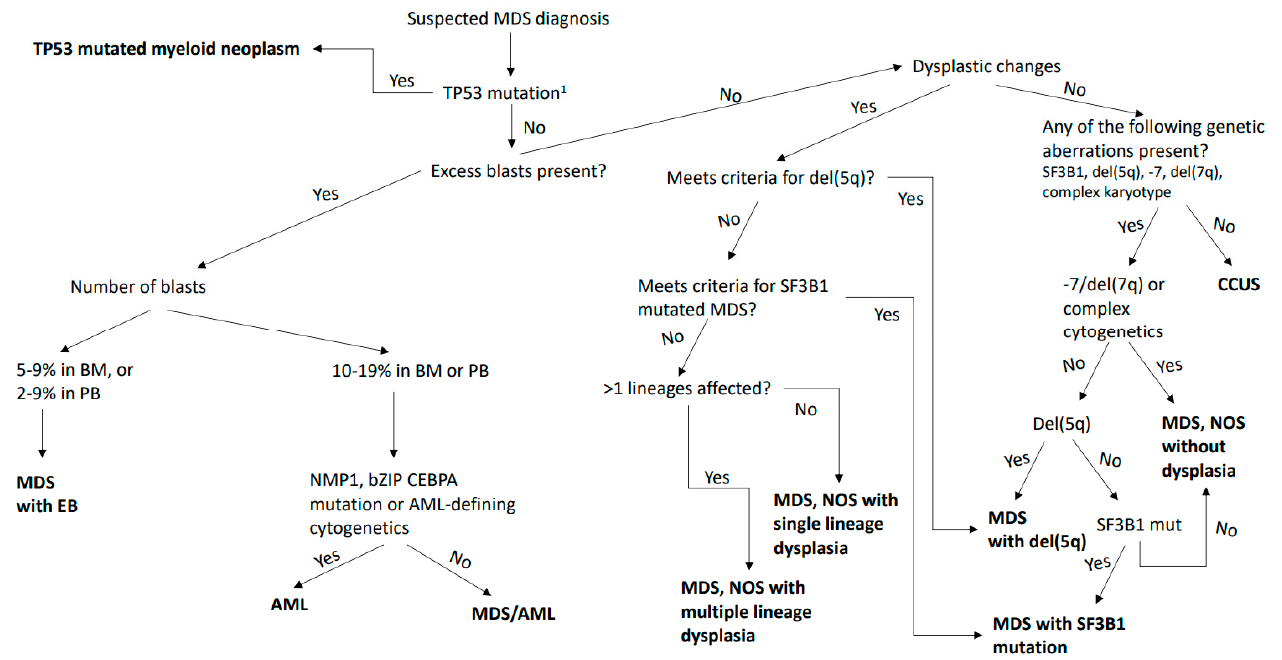
Figure 1. The classification algorithm of MDS based on the new changes. 1 Diagnosis of MDS/AML or AML with mutated TP53 can be made with any somatic TP53 mutation with VAF > 10%, whereas MDS with mutated TP53 requires the presence of a multi-hit TP53 mutation or a TP53 mutation (VAF > 10%) and a complex karyotype, often with loss of 17p if LOH information is not available. A multi-hit TP53 mutation is defined as either two distinct TP53 mutations, each with VAF > 10%, or a single TP53 mutation with either 17p deletion on cytogenetics, VAF ≥ 50%, or copy-neutral LOH at the 17p locus. Abbreviations: MDS, myelodysplastic syndromes; AML, acute myeloid leukemia; EBs, excess blasts; NOS, not otherwise specified; CCUS, clonal cytopenia of undetermined